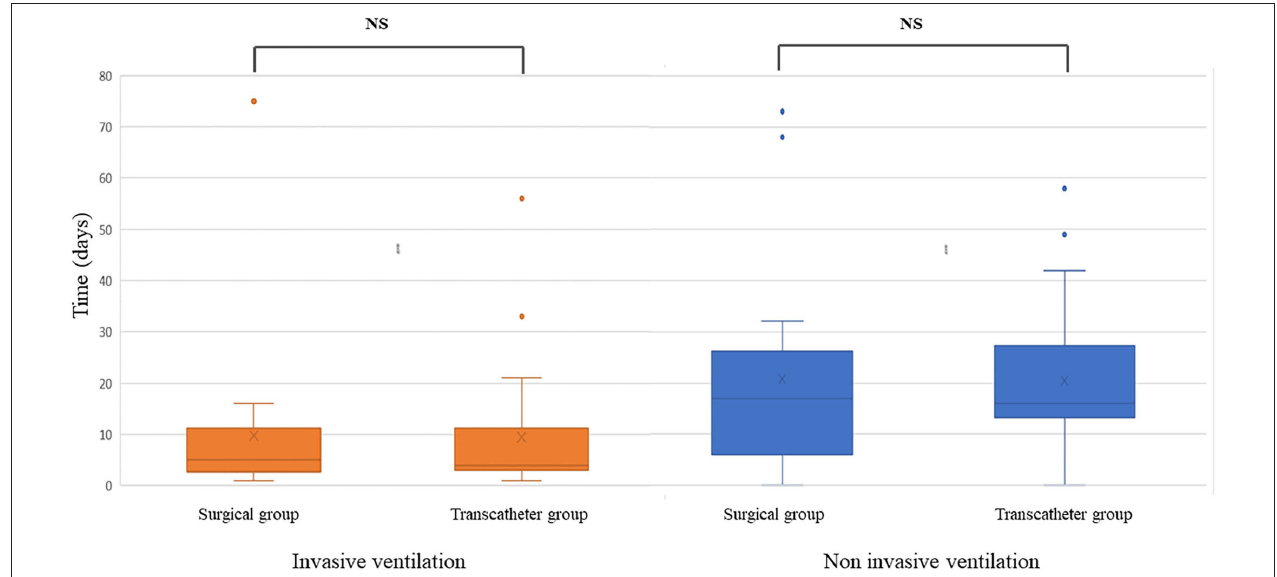
FIGURE 3 | Duration of invasive and non-invasive ventilation after patent ductus arteriosus surgical or percutaneous closure.